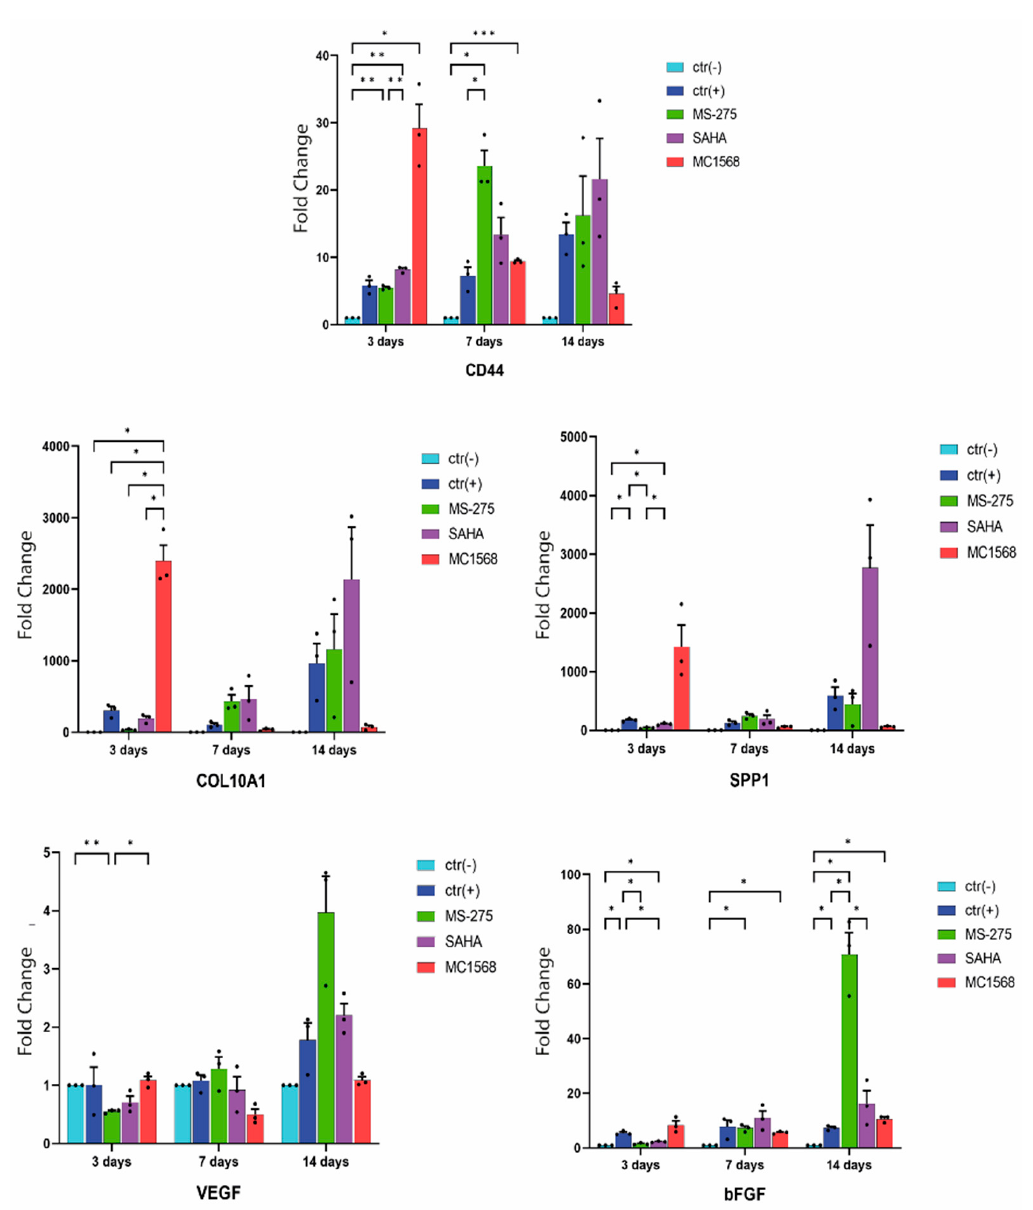
Figure 3. The qRT-PCR analysis for chondrocyte differentiation markers of amniocytes treated or not treated with the different protocols, presented as the fold change (2 −ΔΔ CT ) in the level of their expression, which has been normalized to the reference gene GAPDH. The points represent the mean value ± SD (three independent experiments). Two-way ANOVA statistical analyses were performed using GraphPad Prism v9.4.0. The multiple comparison was performed by comparing the mean value of each treated group with the others over time. Tukey’s test was used to correct for multiple comparisons. The asterisks show the significances of the adjusted p -values. * p < 0.05; ** p < 0.01; *** p < 0.005.